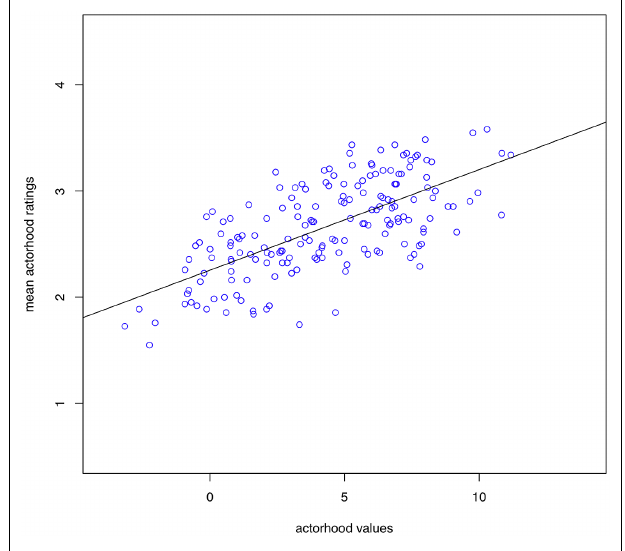
FIGURE 2 |Visualization of the cross-validation analysis. Correlation between the actorhood values for individual nouns derived from the structural equation model in Figure 1 and participants’ ratings of actor goodness in the validation